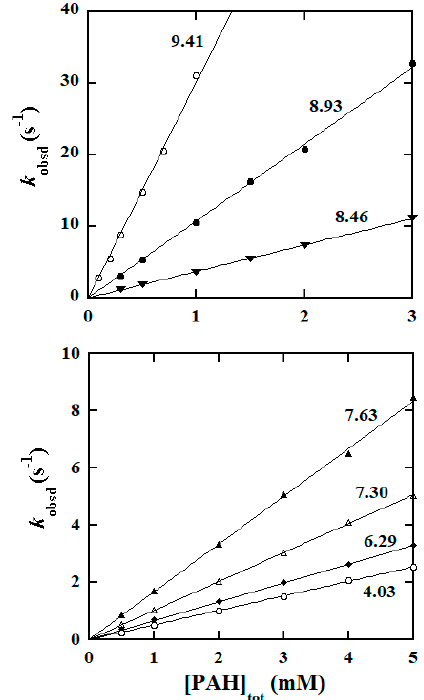
Figure 3. Plots of k obsd versus [PAH] tot (phenylacetic hydrazide) at 25.0 °C and different pHs with the numbers around the lines indicating the pH values.